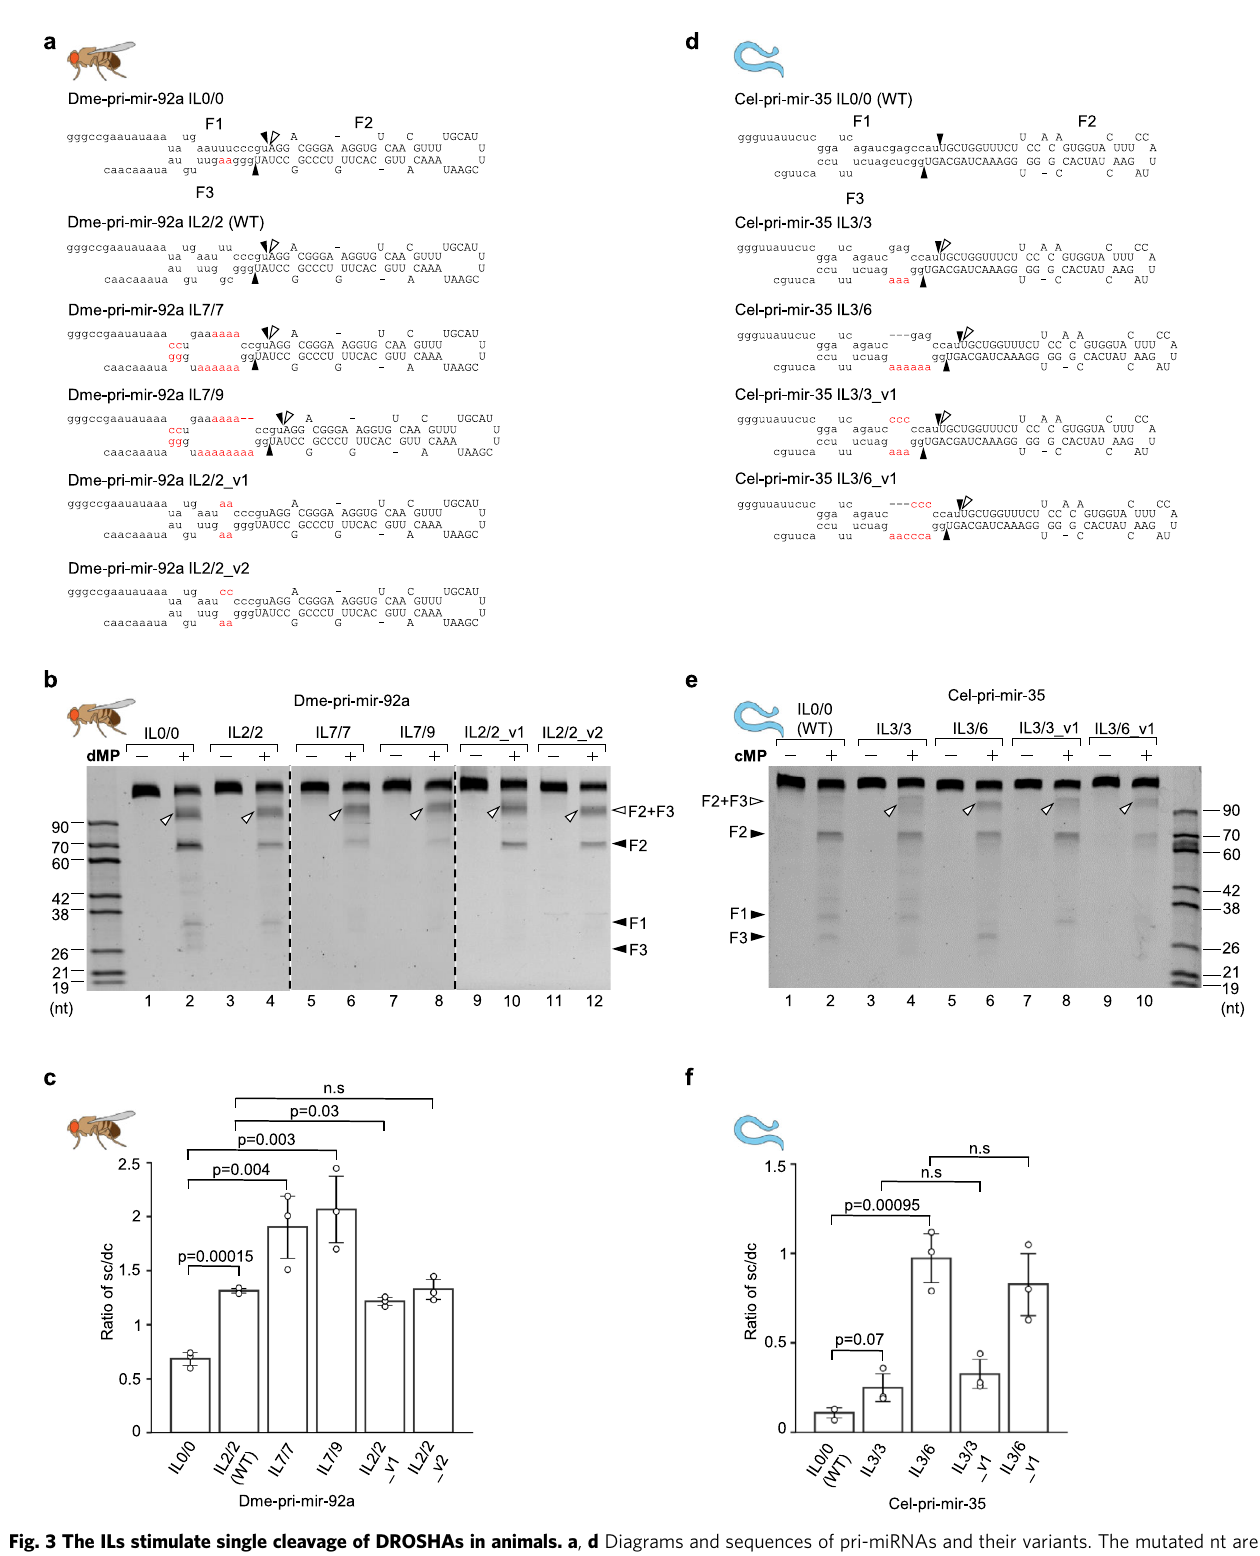
COMMUNICATIONS BIOLOGY| (2021) 4:1332